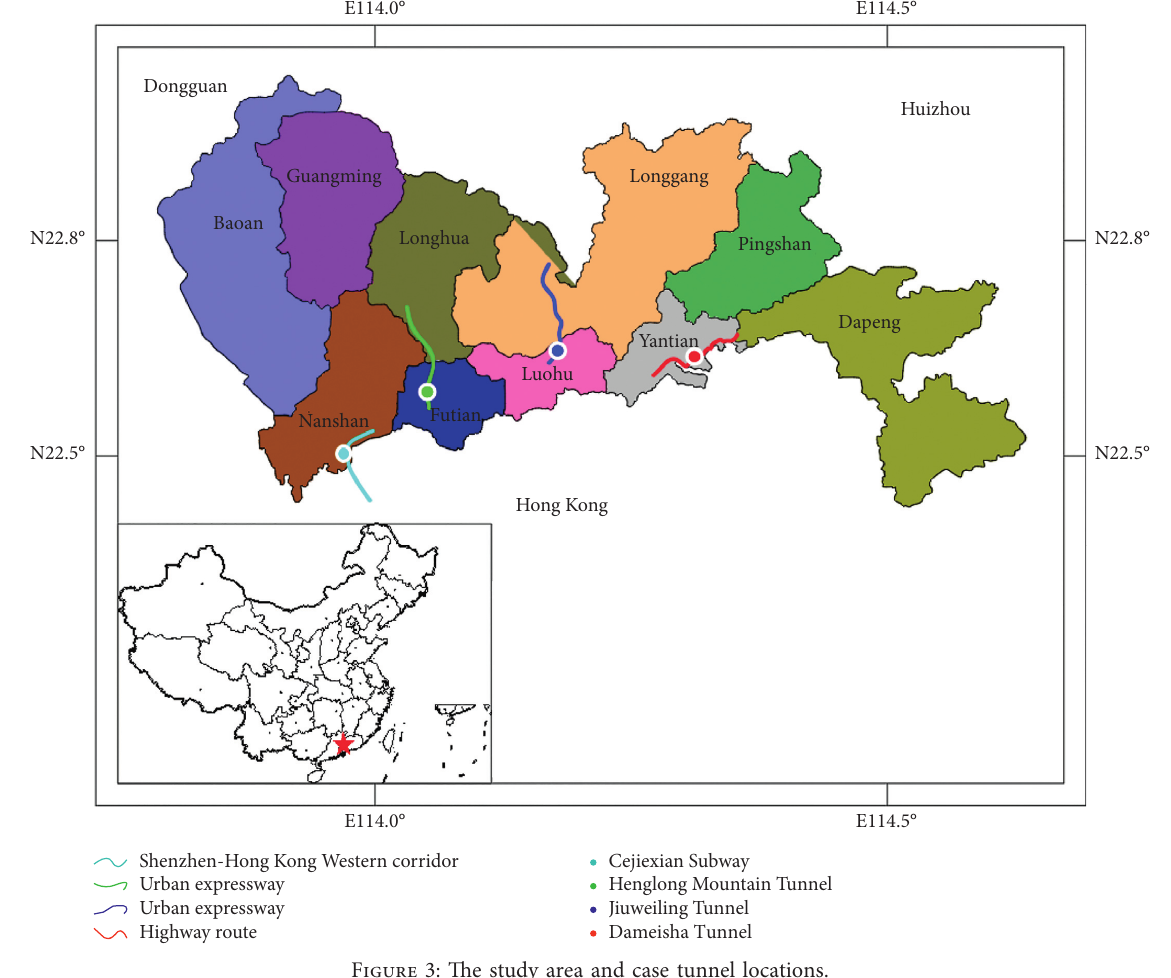
Figure 3: The study area and case tunnel locations.